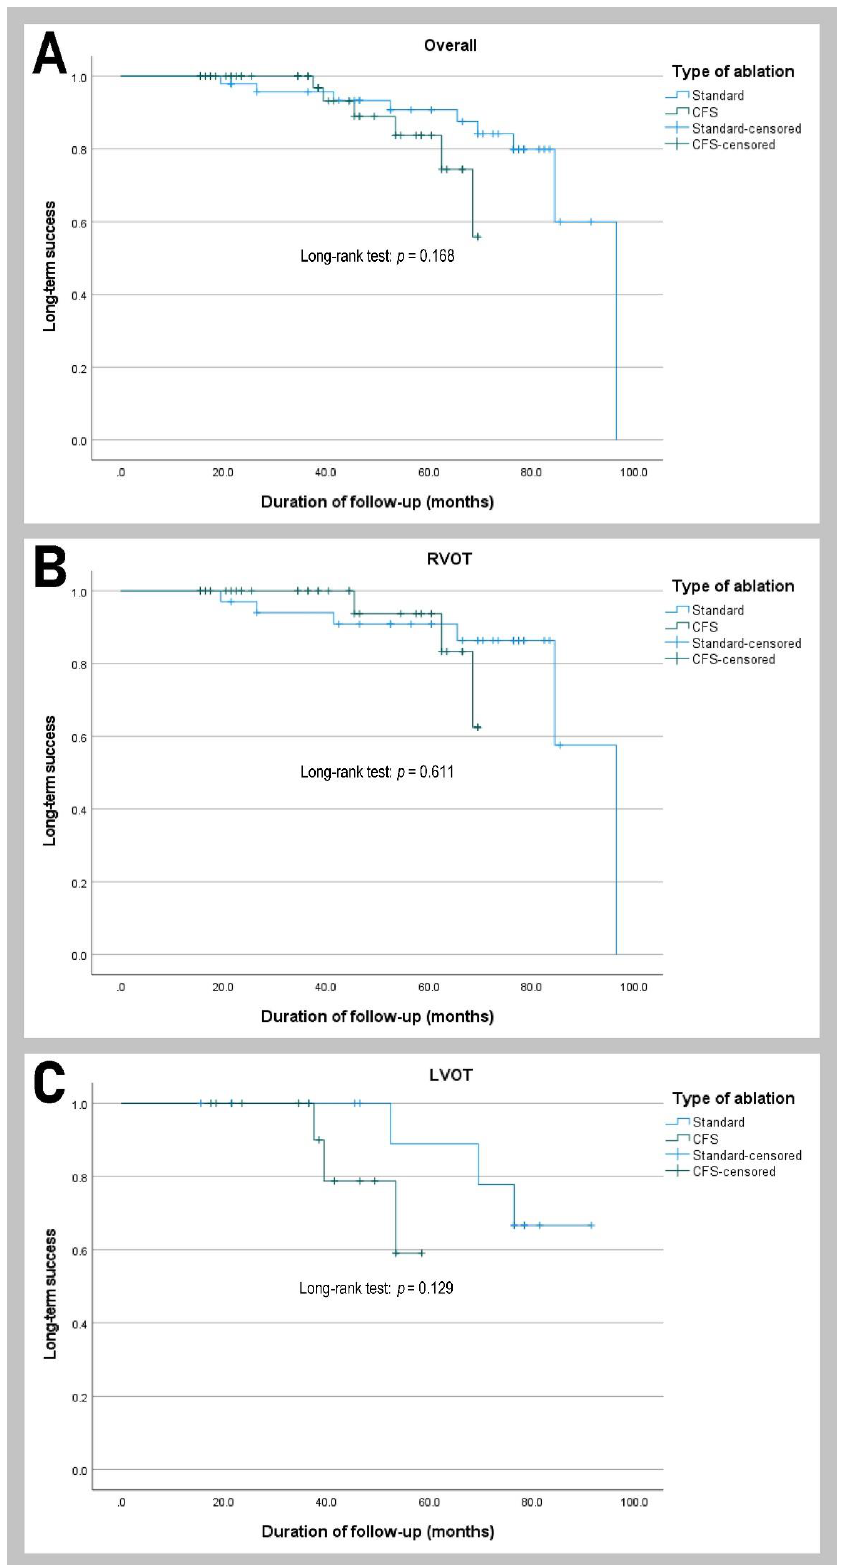
Figure 5. Kaplan–Meier curves of the long-term ablation success of the premature ventricular contractions according to catheter type and arrhythmia localization. ( A ) overall, ( B ) RVOT group, ( C ) LVOT group. Abbreviations: CFS—contact force-sensing; LVOT—left ventricular outflow tract; RVOT—right ventricular outflow